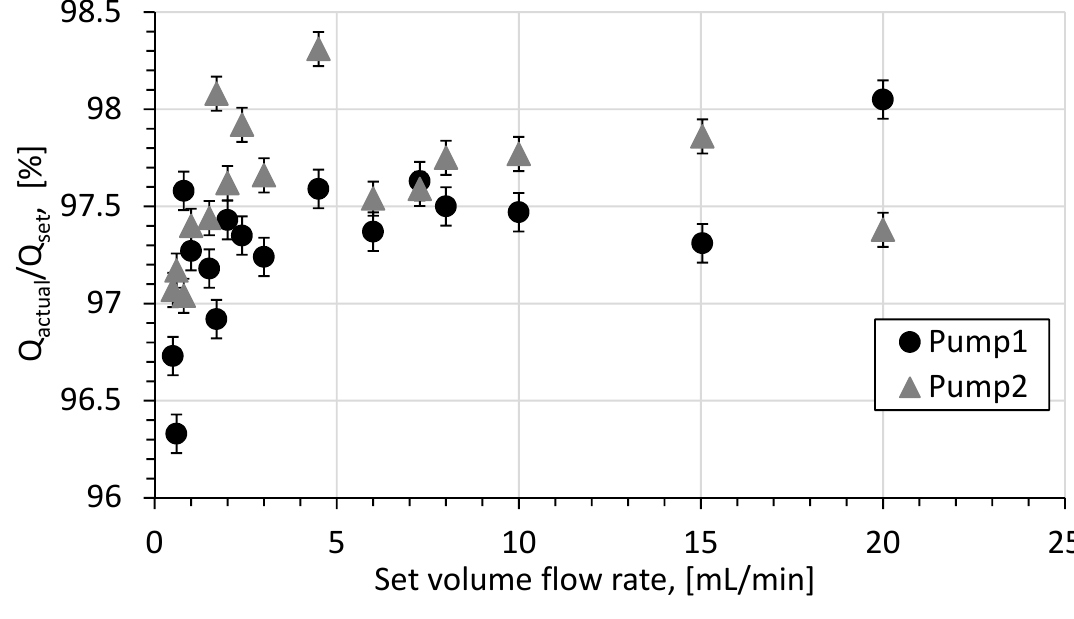
Figure 6. Calibration of the pumps.